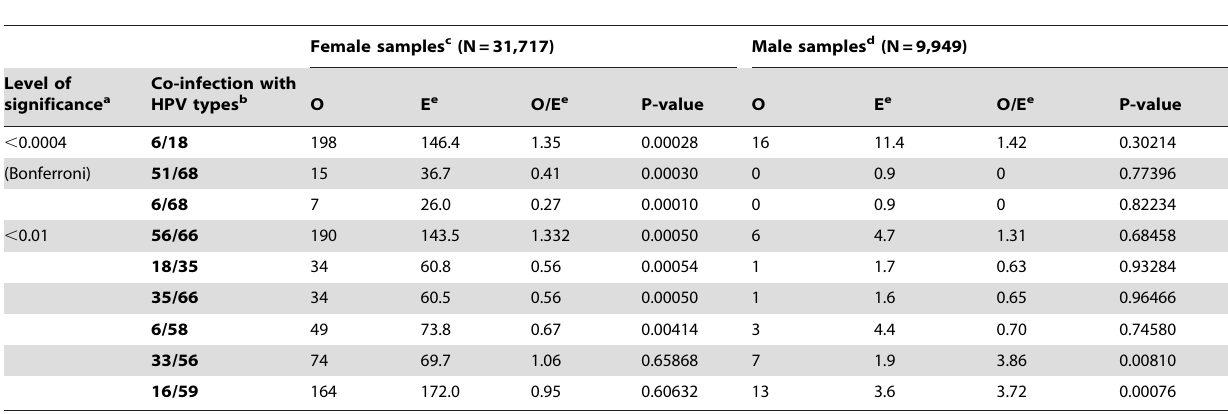
Table 2. Human papillomavirus types showing significant excess or deficit in 2-type co-infections, Sweden.